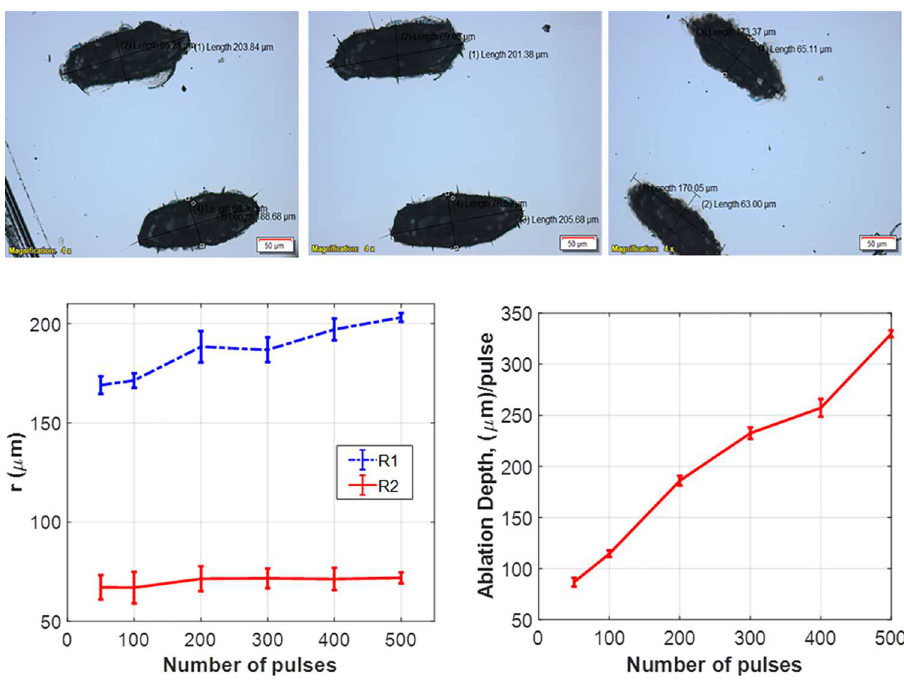
Fig 4. (a) Ablation in PMMA at different number of pulses obtained with polarized microscope, (b) variation of the ellipse diameters with the number of applied pulses, and (c) change in the ablation depth with the number of applied pulses.